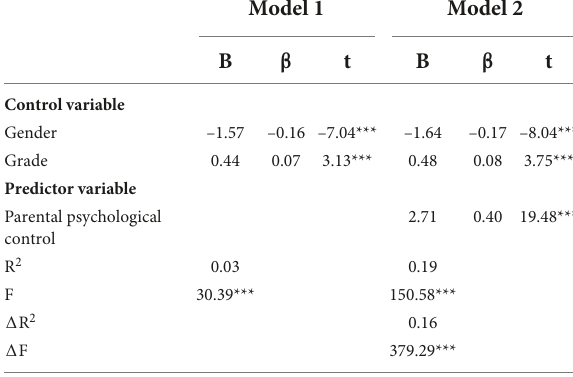
Grade:2=grade9,1=grade8and0=grade7.Gender:1=maleand0=female. *** p <